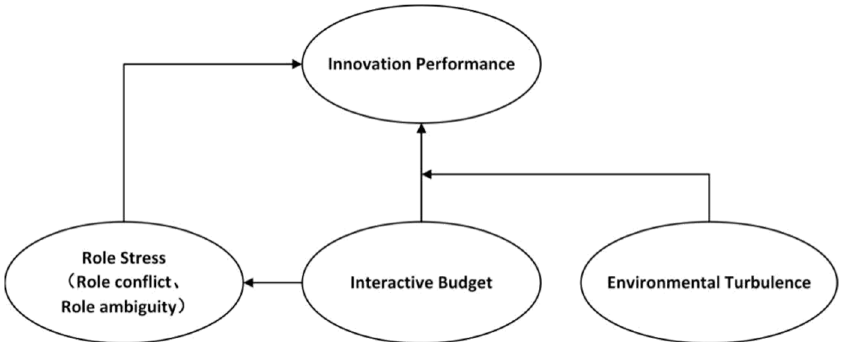
Figure 1. Research